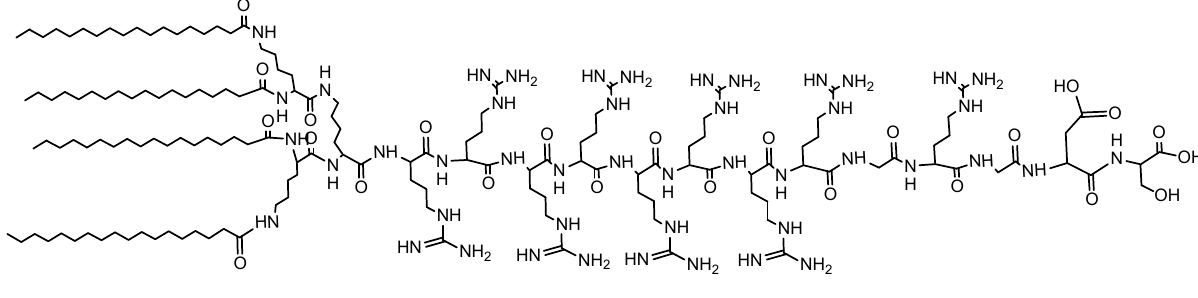
Figure 10. Structure of a surfactant-like tetra-tail amphiphilic